Question: Does the plotted quantity increase or decrease?
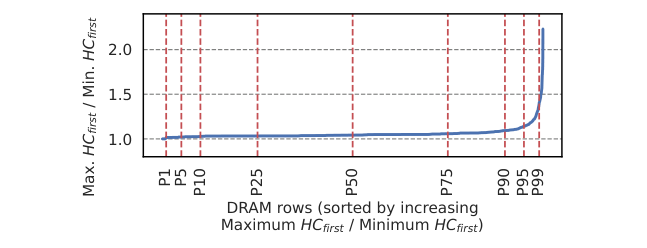
Answer: increasing